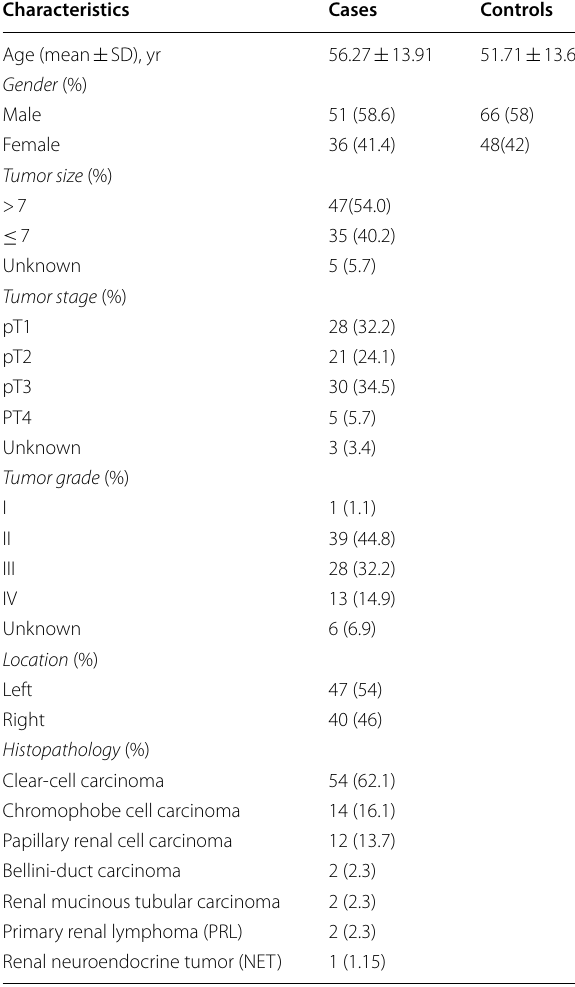
Table 1 Demographic and clinical characteristics of RCC cancer cases and controls